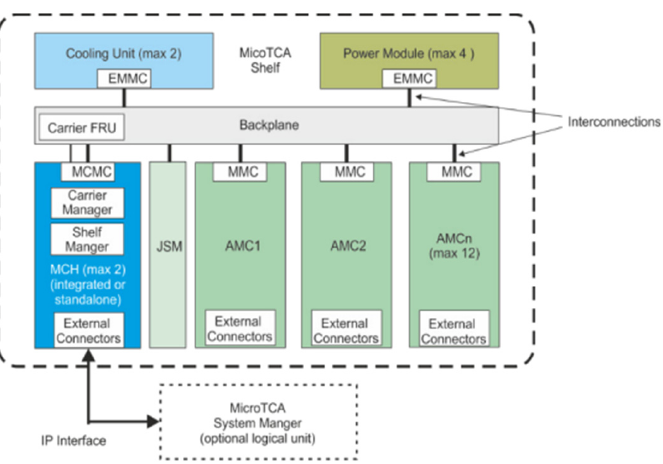
Figure 7. Block diagram of a μ TCA system.